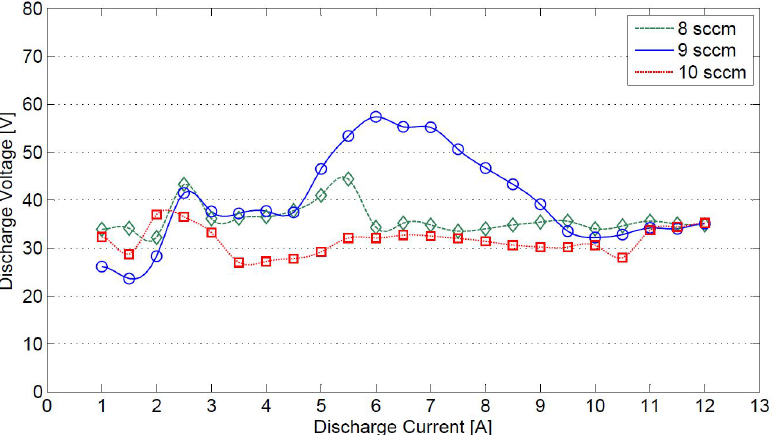
Figure 13. Coaxial hollow cathode discharge voltage vs. discharge current for different Argon flow rates.